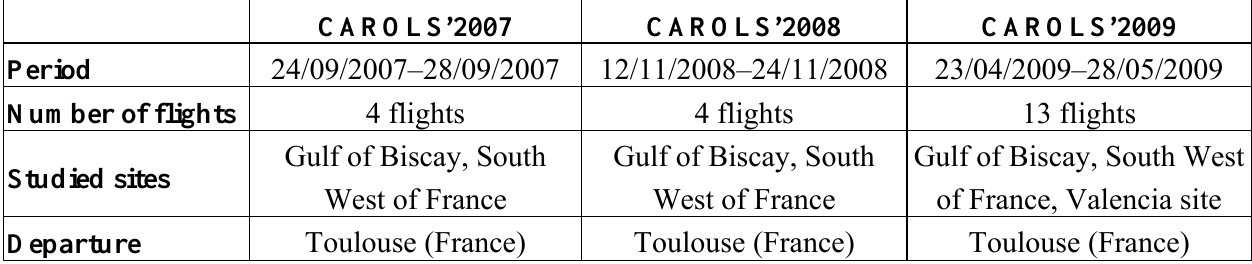
Table 2. Description of the flights undertaken during the CAROLS